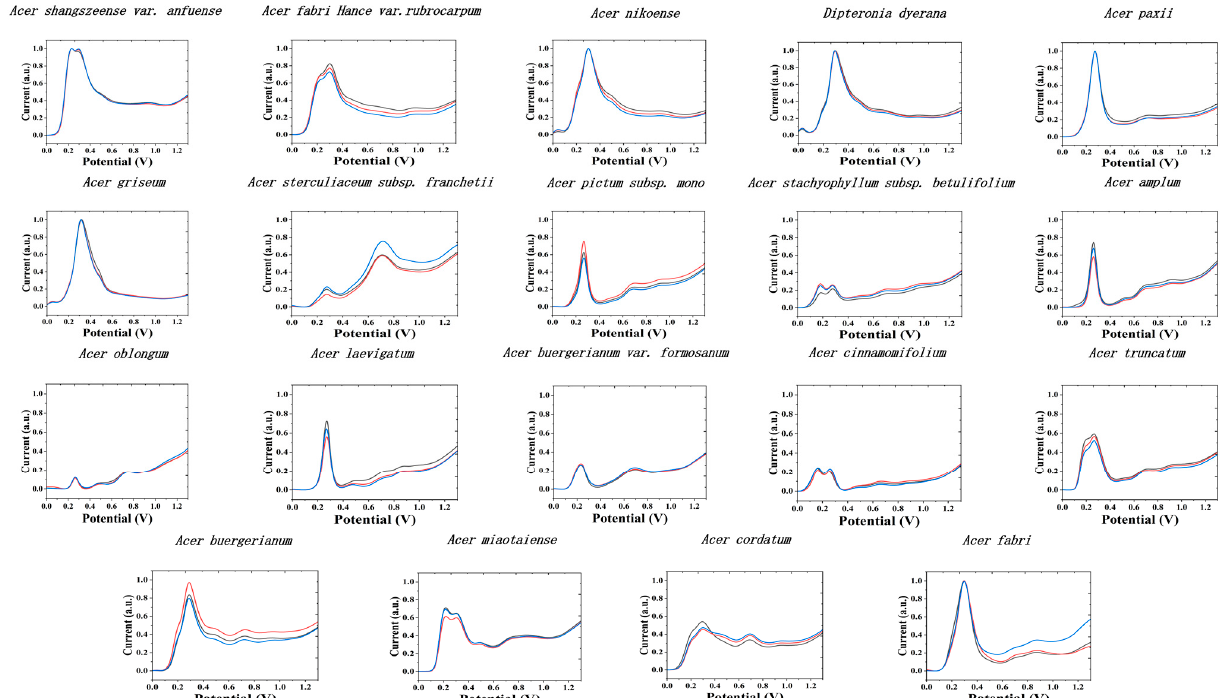
Figure 1. Electrochemical fingerprint of A. shangszeense var. anfuense , A. pictum subsp. mono , A. amplum , A. truncatum , A. miaotaiense , A. nikoense , A. griseum , A. fabri Hance var. rubrocarpum , A. paxii , A. oblongum , A. laevigatum , A. buergerianum var. formosanum , A. cinnamomifolium , A. buergerianum , A. cordatum , A. fabri , A. sterculiaceum subsp. Franchetii , A. stachyophyllum subsp. betulifolium , and Dipteronia dyerana after water extraction and recording in PBS (0.1 M, pH 7) condition.